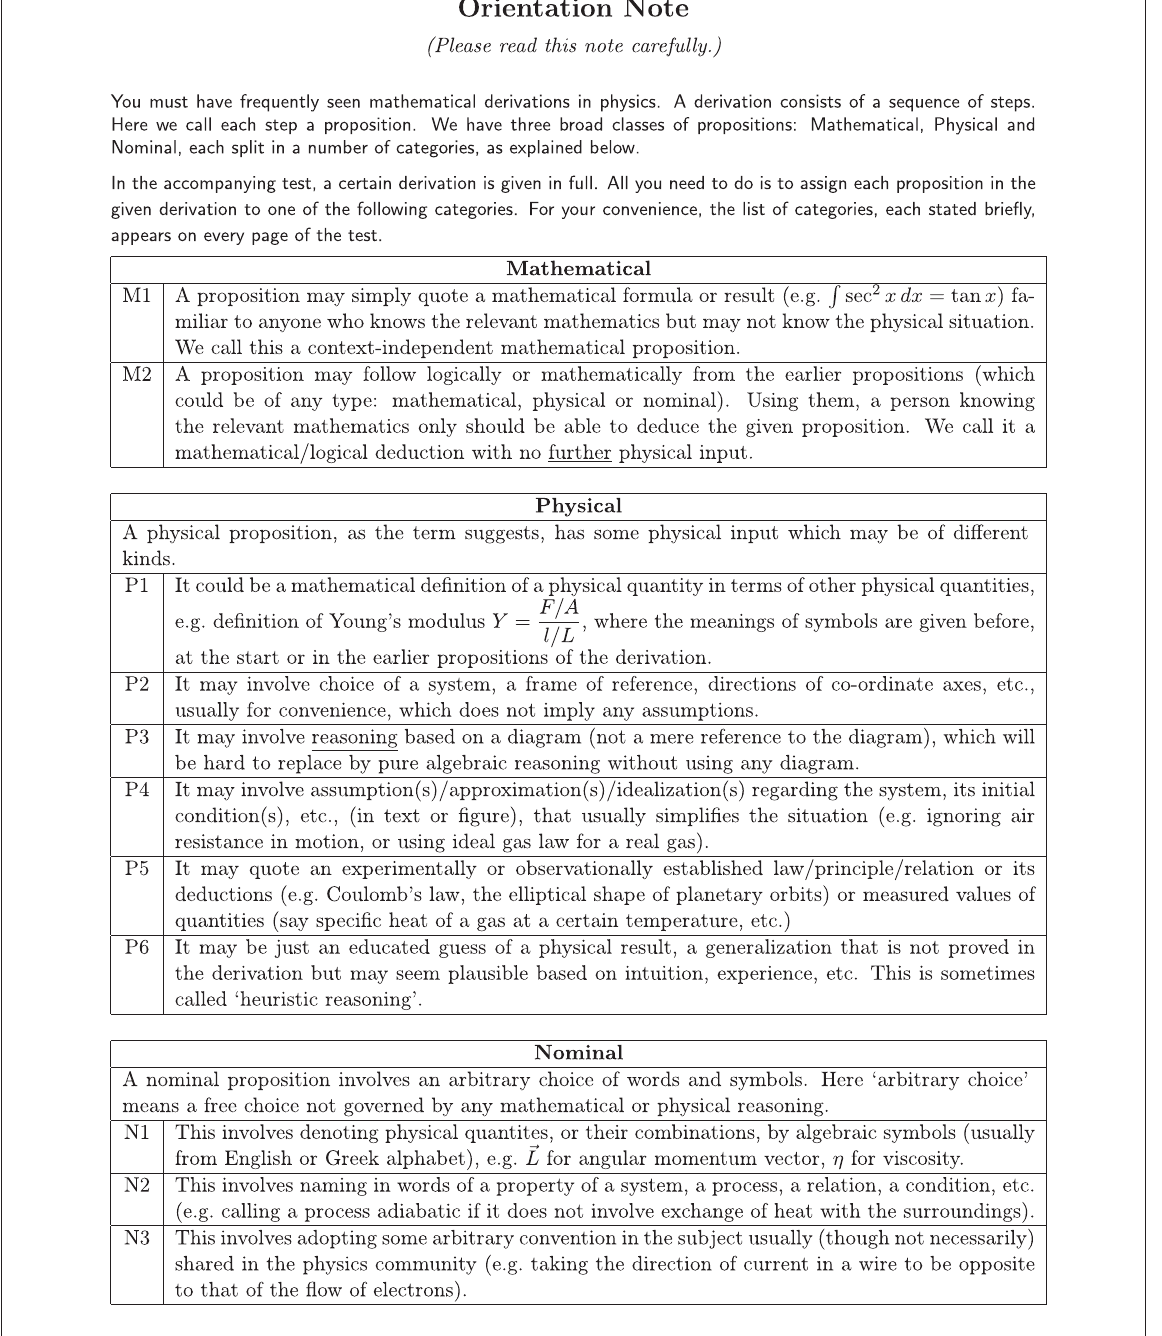
FIG. 14. Diagnostic tool for epistemic understanding: (I) Orientation note. Next parts of the tool in Figs. 15 –